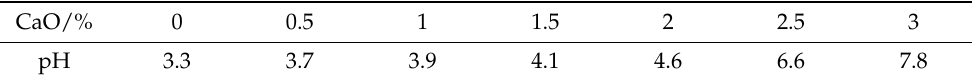
Table 4. Effect of quicklime addition on pH value of polyaluminum chloride